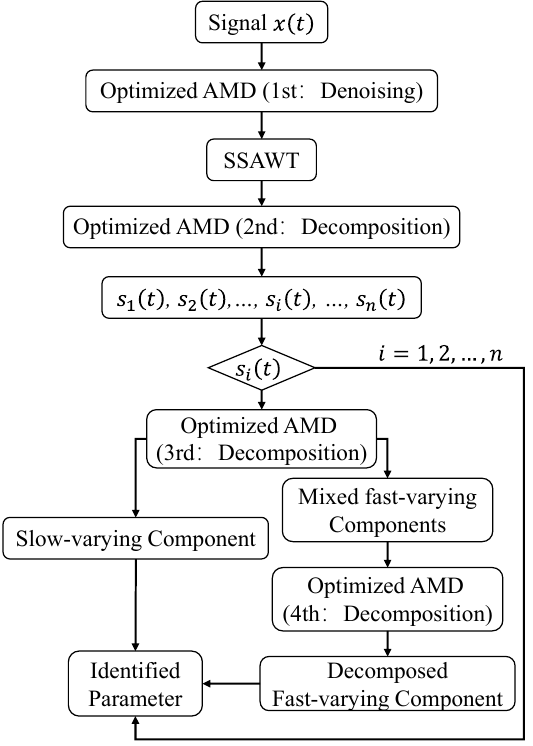
Figure 1. SSAWT-oMAMD algorithm.